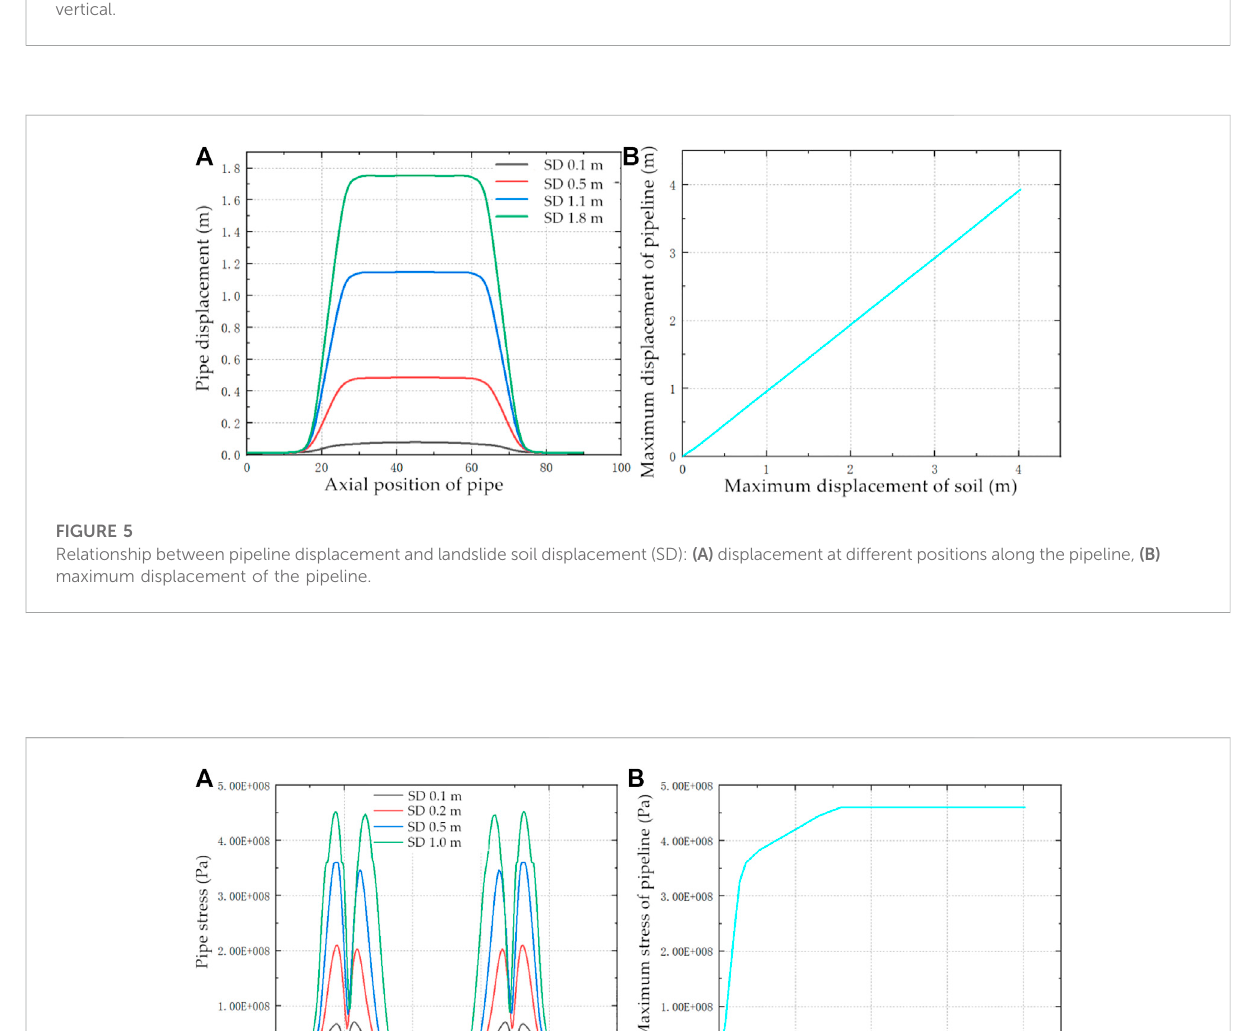
Variation diagram of the landslide reduction coef fi cient for pipelines passing through the landslide at different orientations: (A) horizontal, (B) vertical.